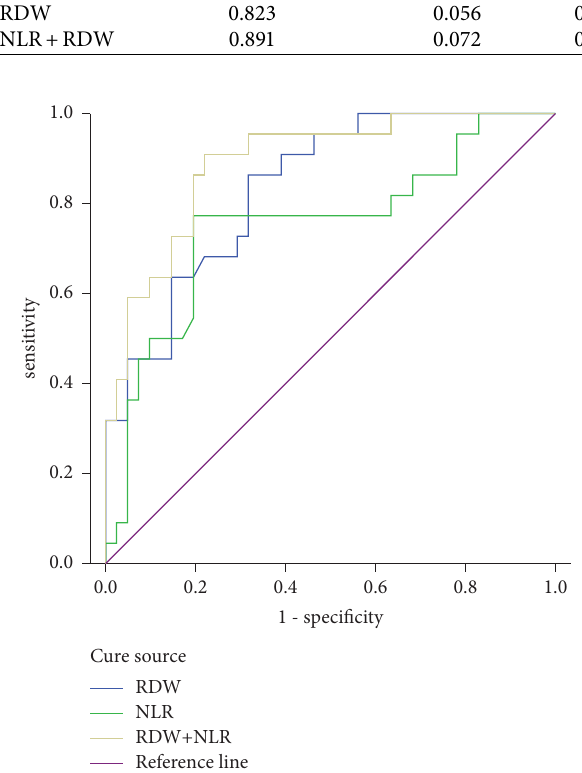
Figure 1: ROC curve of prognostic value of NLR, RDW, and the combination of the two indexes in emergency sepsis patients.